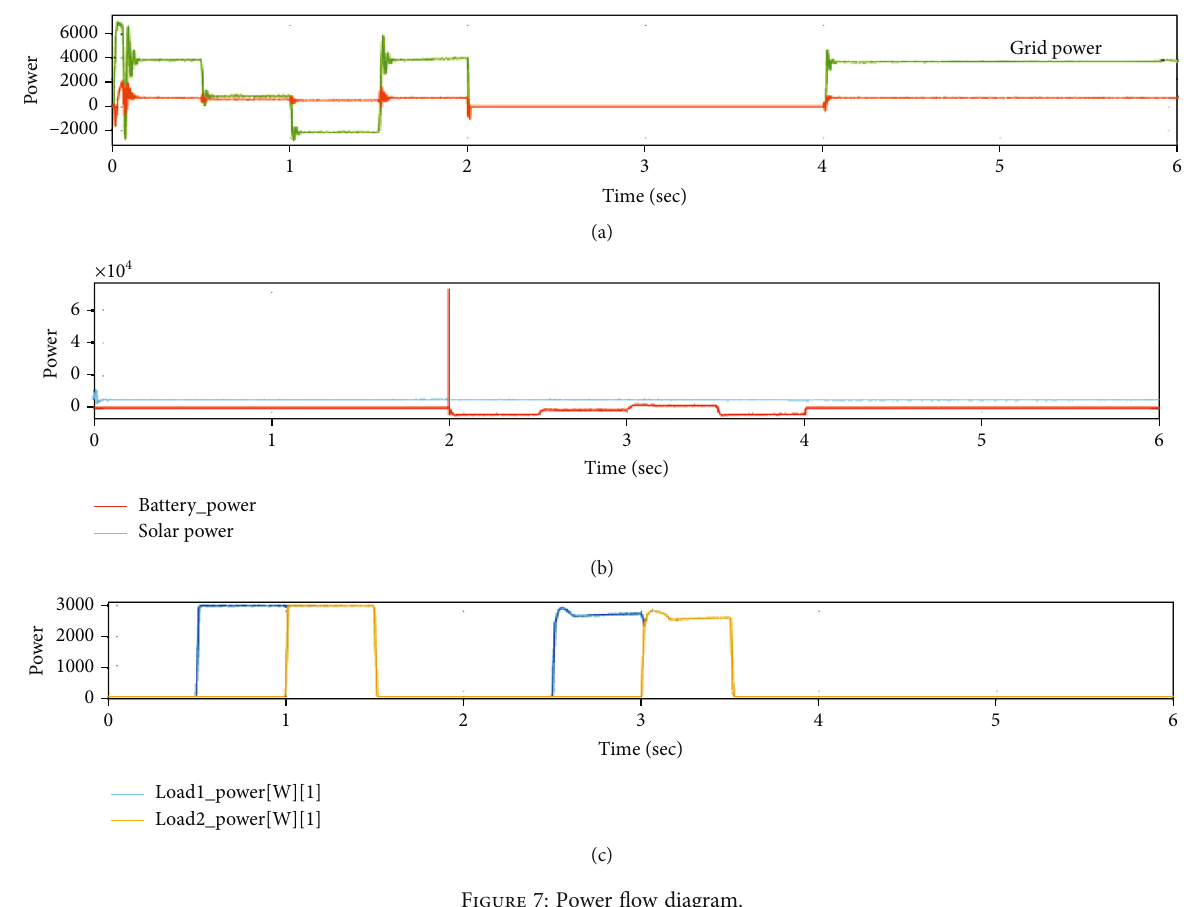
Figure 7: Power fl ow diagram.